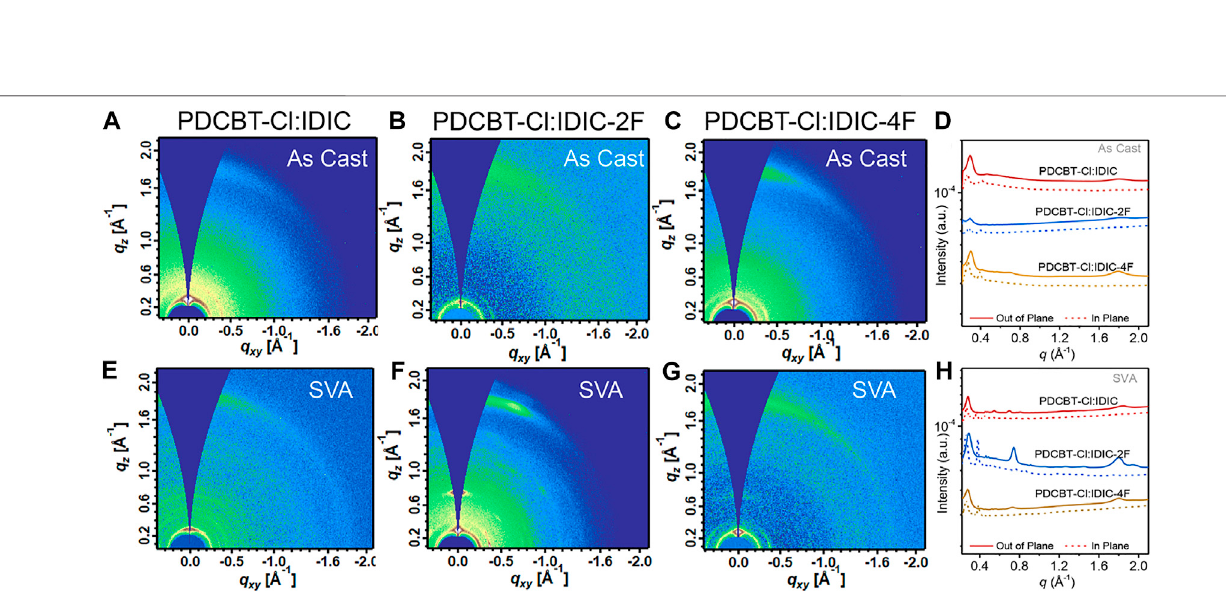
Frontiers in Chemistry |